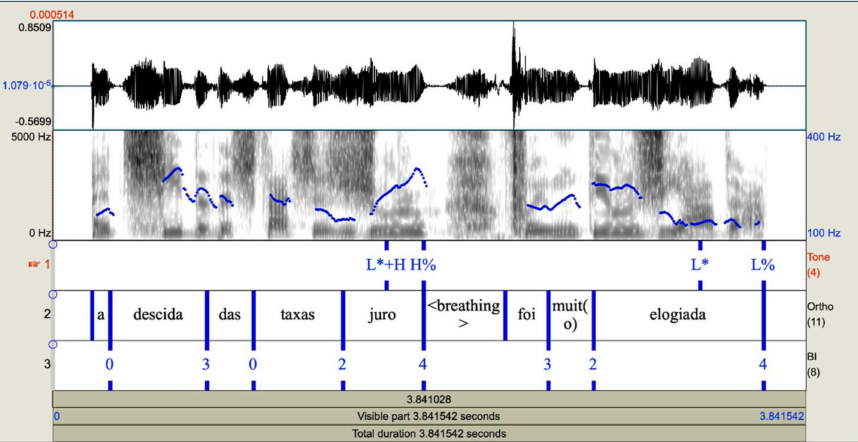
Figure 1. Textgrid with three tiers for annotation: tone, orthography, and break